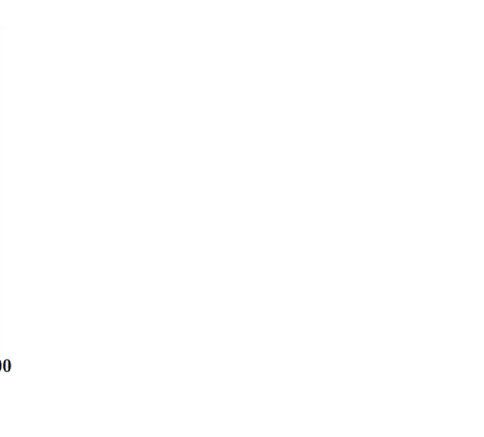
Figure 6. TG curves of PEG-NH 2 , ZIF-8 and ZIF-8/PEG-NH 2